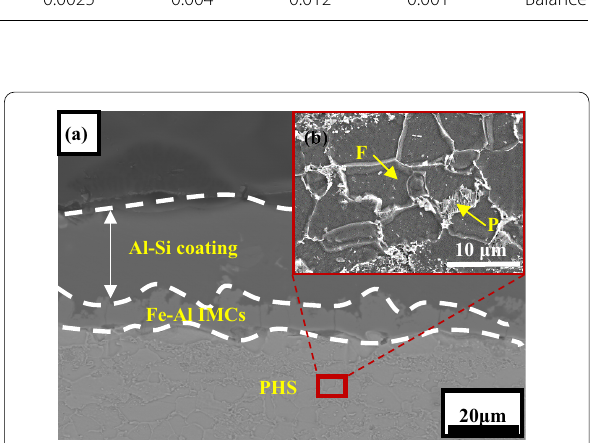
Figure 1 The microstructure characterization of Al-coating on PHS: a Coating distribution, b microstructure